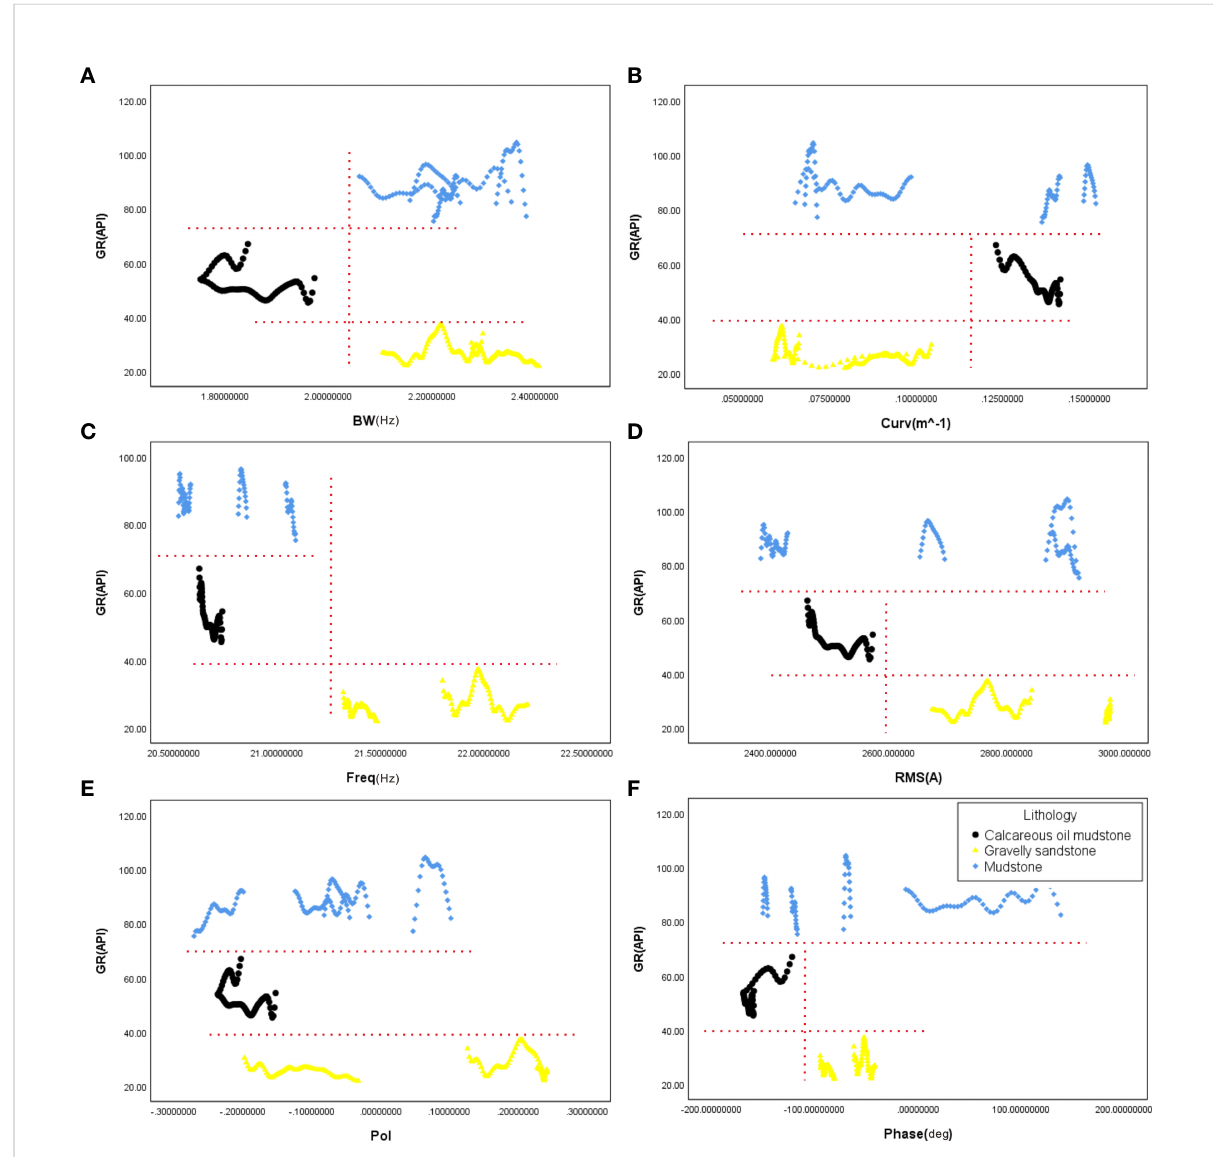
FIGURE 7 Well Che66 GR-Seismic attribute crossplot. (A) GR-BW crossplot; (B) GR-Curv crossplot; (C) GR-Freq crossplot; (D) GR-RMS crossplot; (E) GR-Pol crossplot; (F) GR-Phase